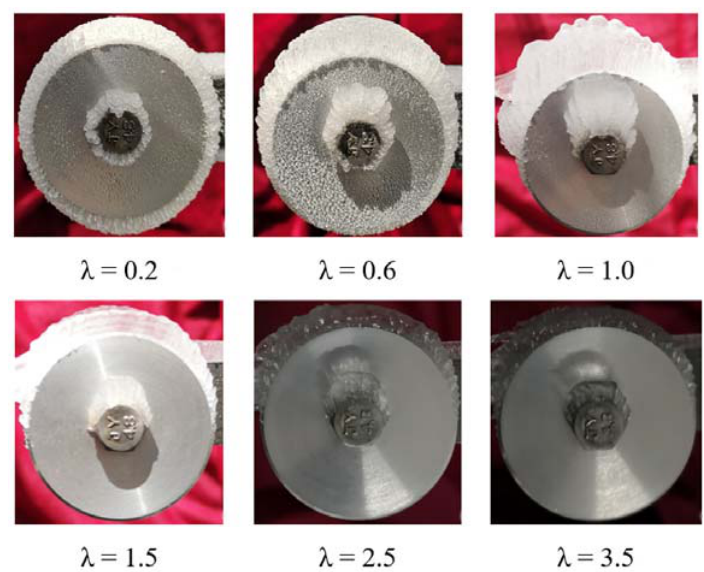
Figure 5. Icing on the cylinder with a diameter of 40 mm.